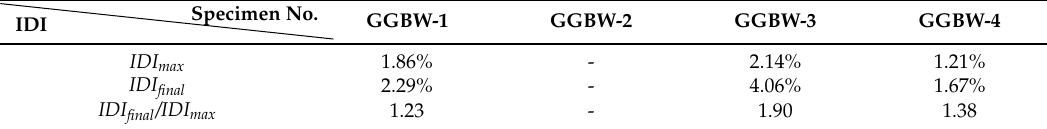
Table 4. The inter-story drift, IDI : the index of inter-storey drift with respect to the storey height. Specimen No. IDI